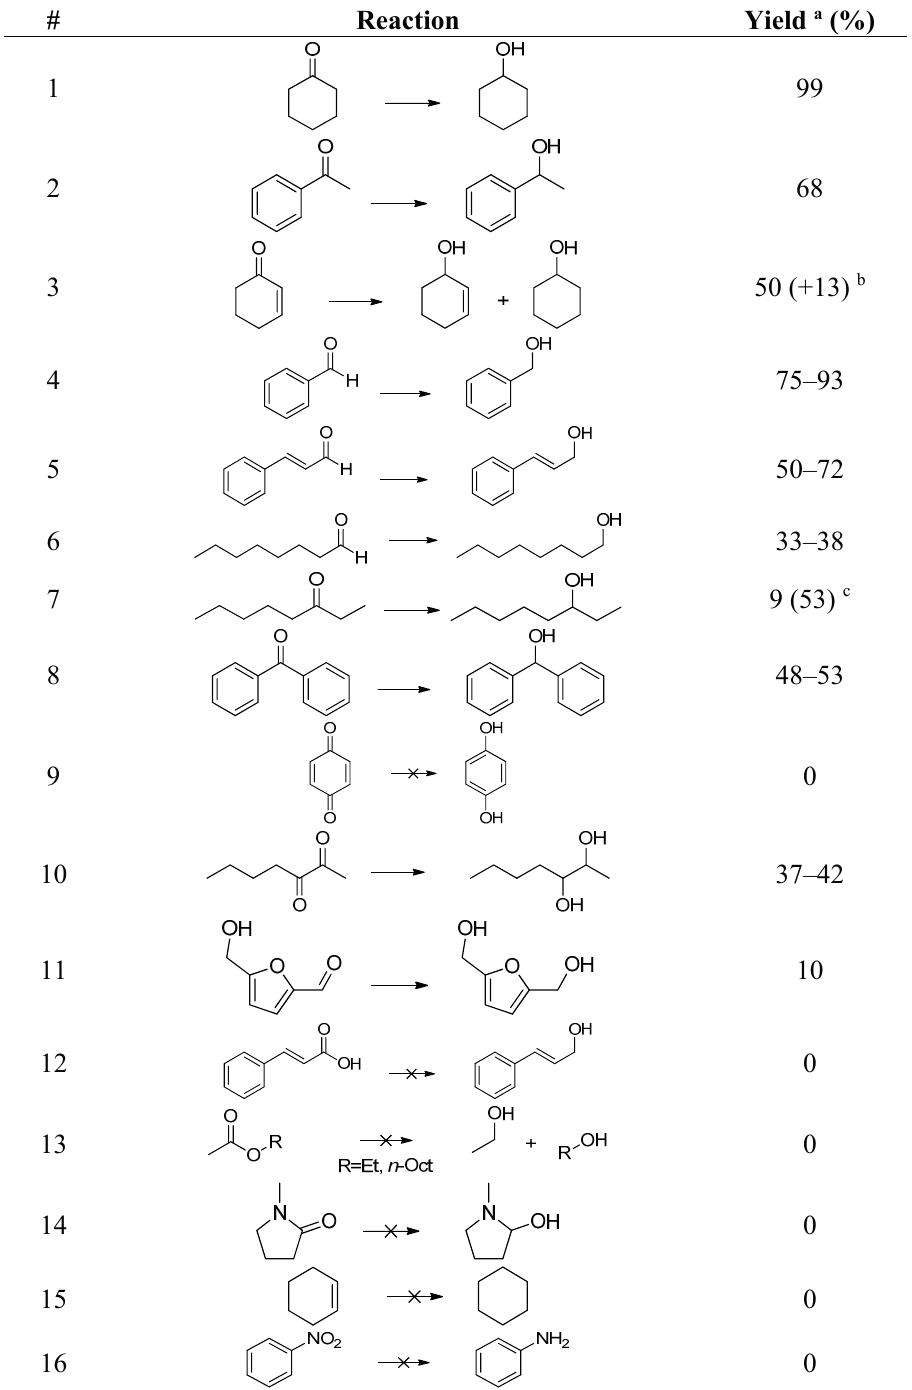
Table 1. Metal-free reductions using EDAB at 80 °C in H 2